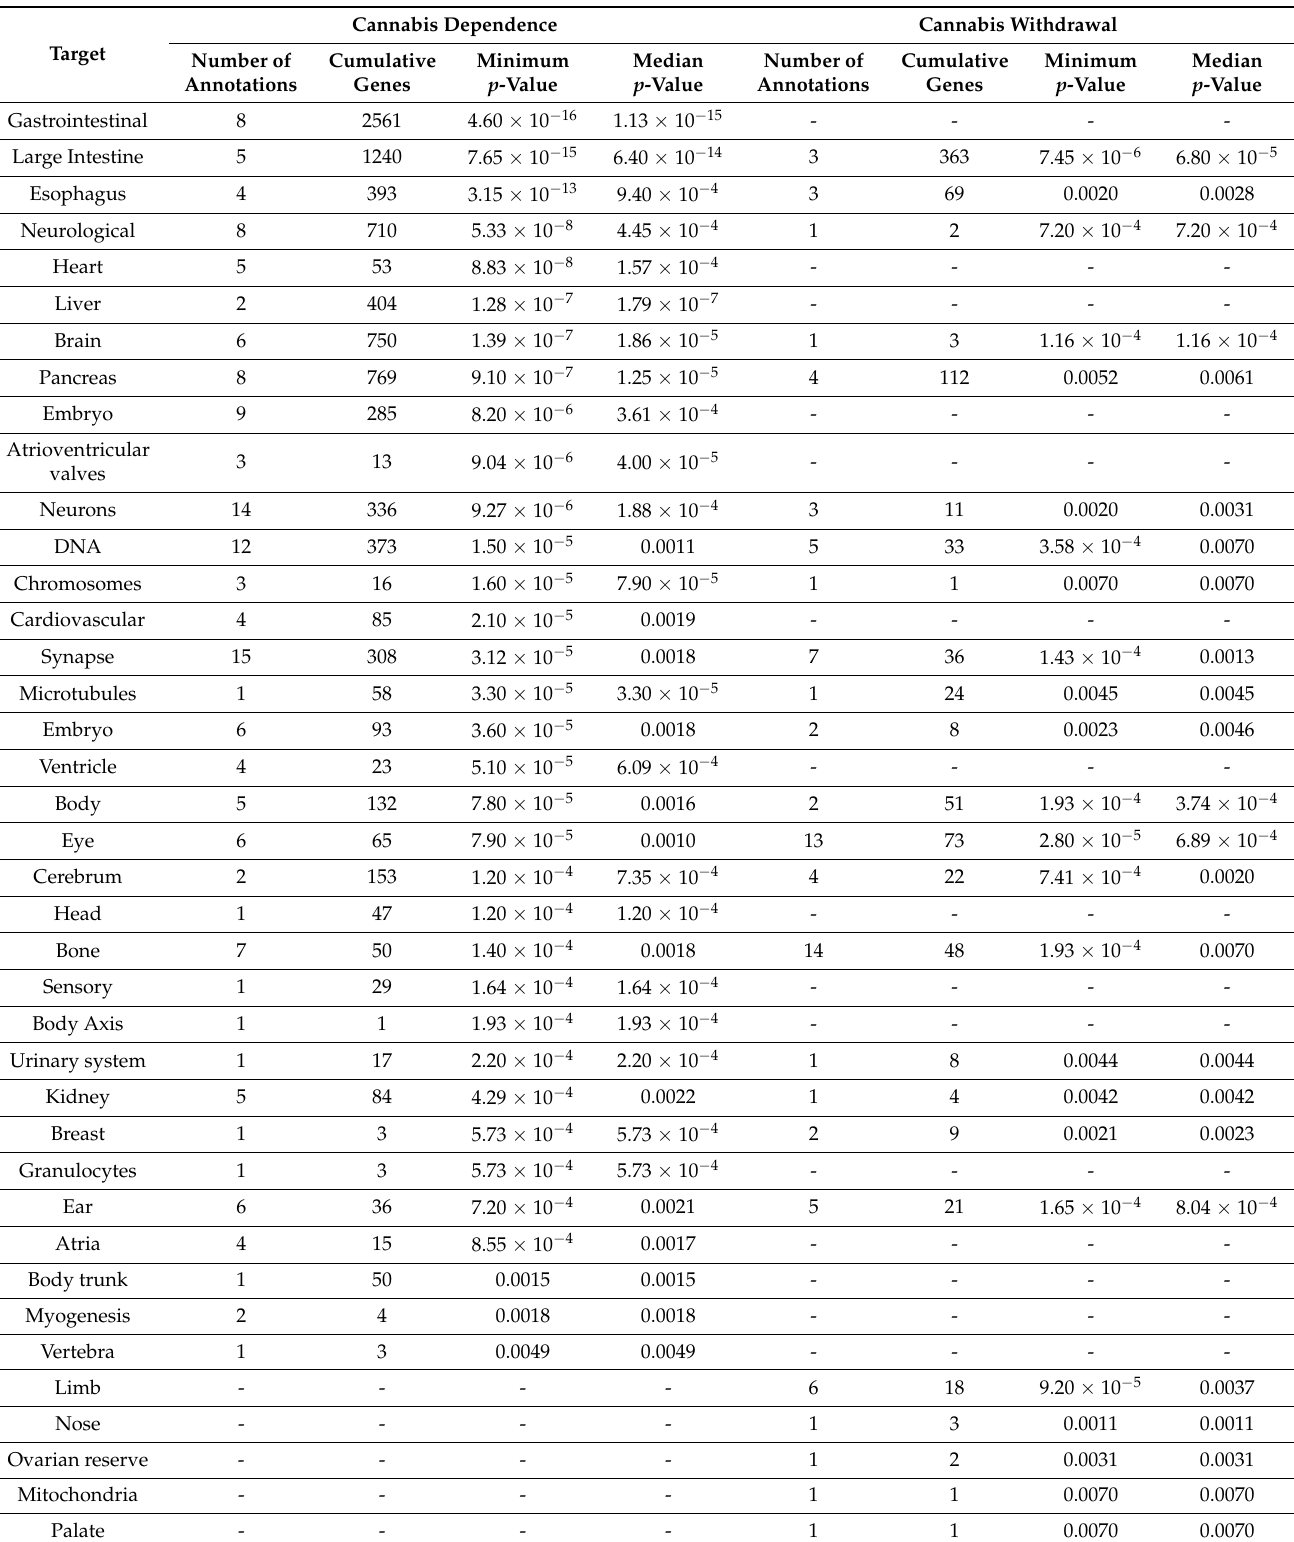
Table 9. Contrast of Epigenomic Hits for All Congenital Anomalies.by Organ Target, Cannabis Dependence vs. Withdrawal, Schrott EWAS